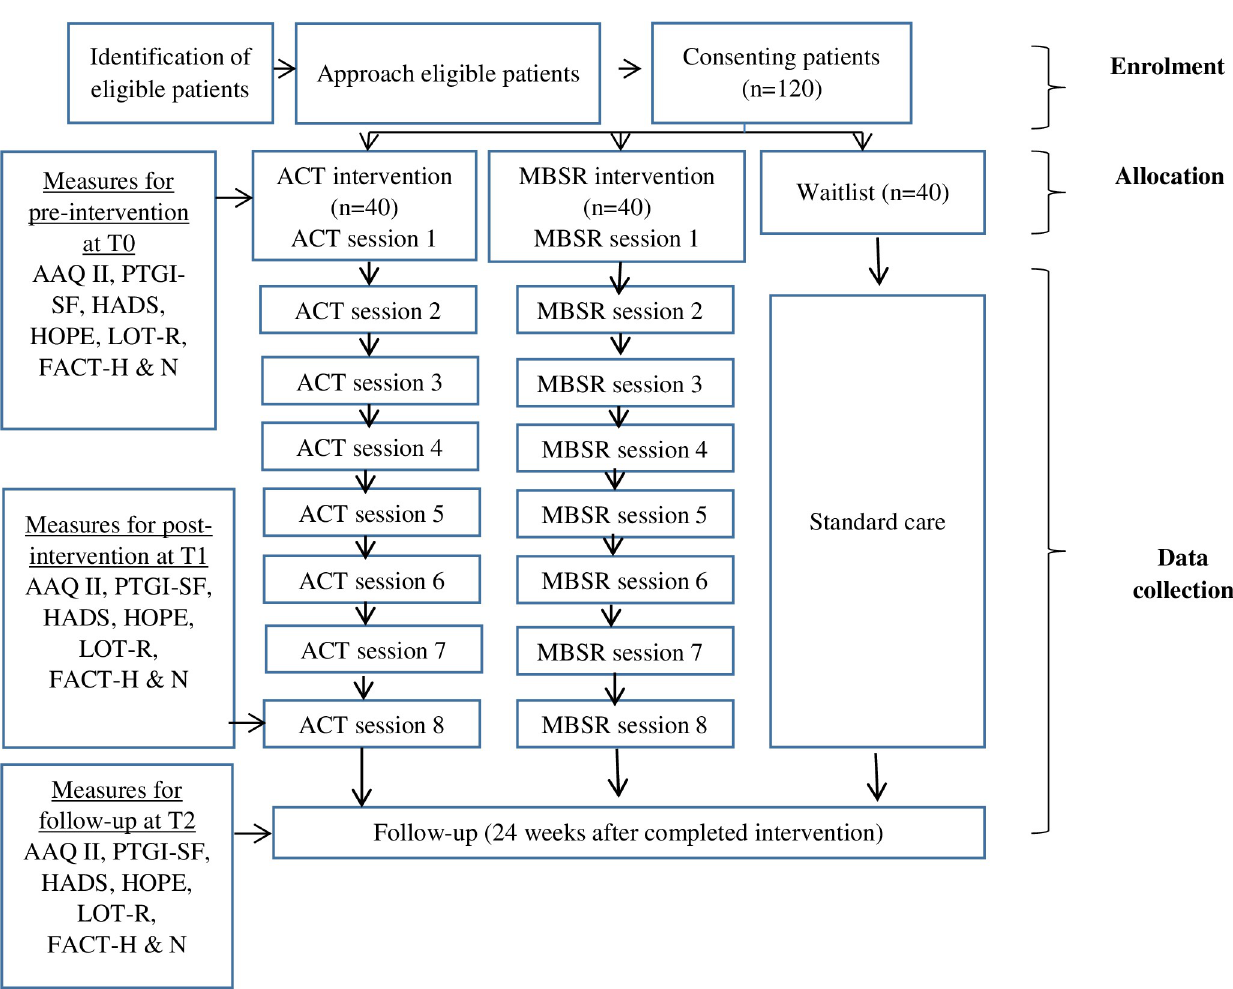
Fig 1. The flow diagram of the study procedures and outcome measures. ACT = acceptance and commitment therapy, MBSR = mindfulness-based stress reduction, AAQ-II = Acceptance and Action Questionnaire version II, PTGI-SF = Posttraumatic Growth Inventory-Short Form, HADS = Hospital Anxiety and Depression Scale, HOPE = Hope Scale, LOT-R = Life Orientation Test-Revised, FACT-H & N = Functional Assessment of Cancer Therapy–Head & Neck, T 0 = pre-intervention assessment, T 1 = immediately post-intervention at 8 weeks, T 2 = 24 weeks after intervention.